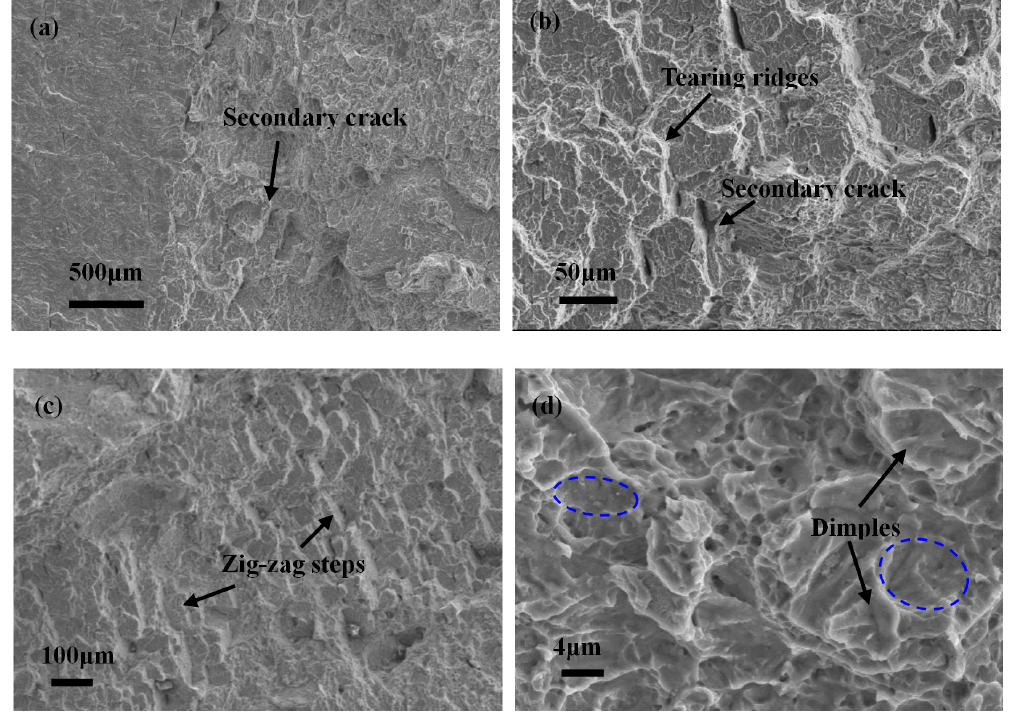
Figure 3. The SEM morphological characteristics of the fracture toughness of the TM fractures: ( a ) the transition region from fatigue crack to tensile crack propagation, ( b ) tear ridges and secondary cracks, ( c ) large fracture steps with a zig-zag fracture pattern, ( d ) big dimples surrounded by ridges.